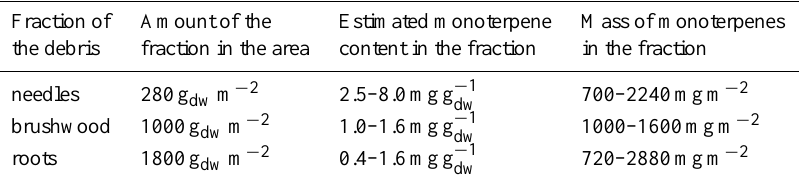
Table 1. The amount, estimated monoterpene content and the resulting monoterpene mass per land area of each of the debris fraction found in the seed tree felling area. Fraction of Amount of the Estimated monoterpene Mass of monoterpenes the debris fraction in the area content in the fraction in the fraction needles 280g dw m − 2